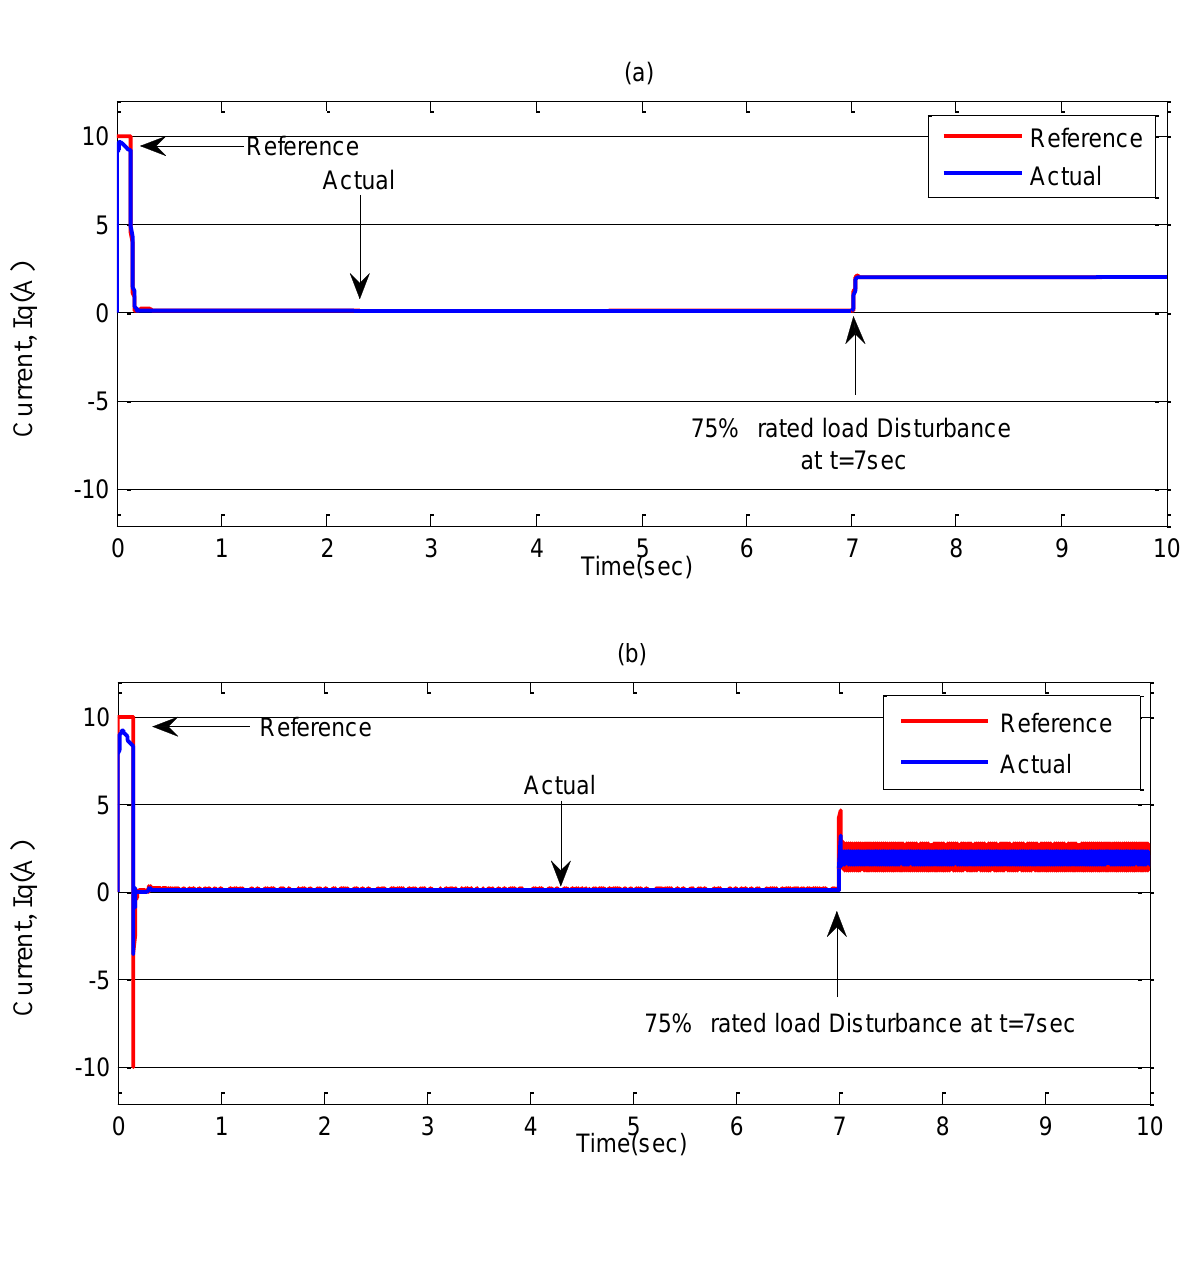
Figure 10. Simulated q-axis current responses-based IM drive in Case-2 ; ( a ) the tuned PI controller, ( b ) the conventional BLFC controller, and ( c ) the proposed NBLFC